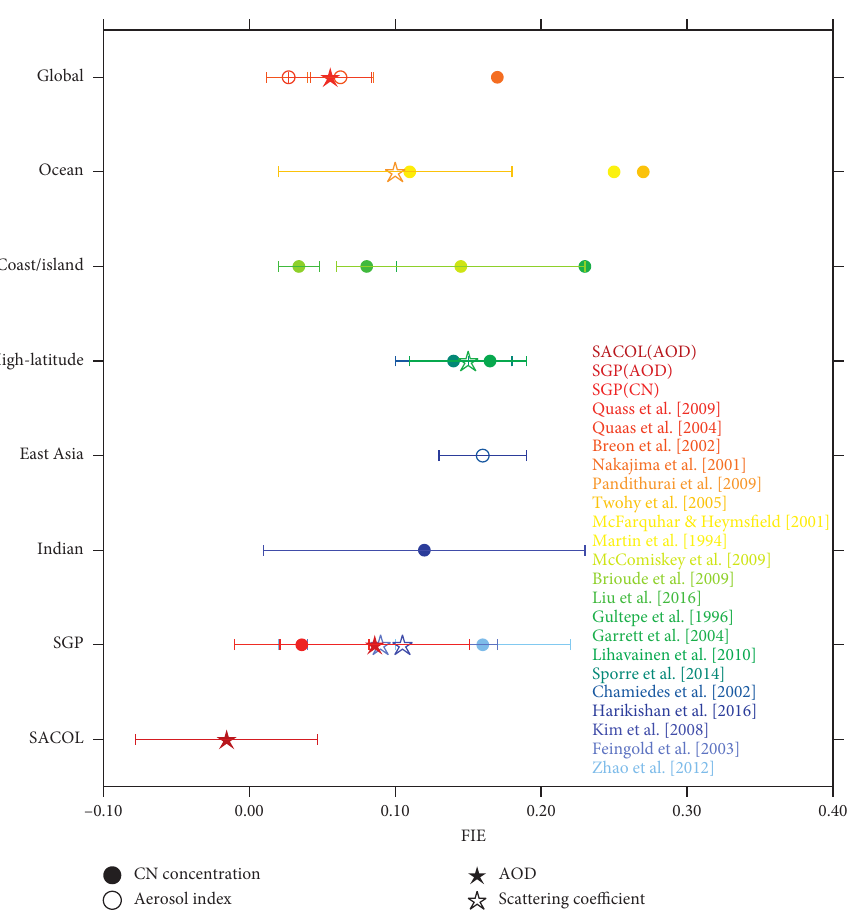
Figure 5: The aerosol first indirect effect (FIE) estimated at the SGP and SACOL sites and from earlier studies. Different CCN proxies used in those studies are sorted out with different symbols.